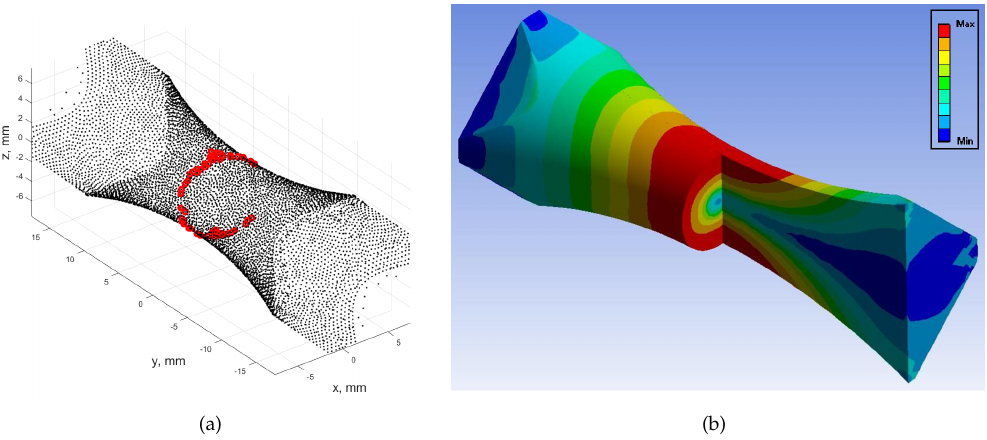
Figure 19. ( a ) Distribution of the most stressed mesh nodes calculated according to the von Mises criterion for in-phase kinematic loading; ( b ) Area of occurrence of plastic strains FEM calculated for the Chaboche cyclic plasticity model for out-of-phase kinematic